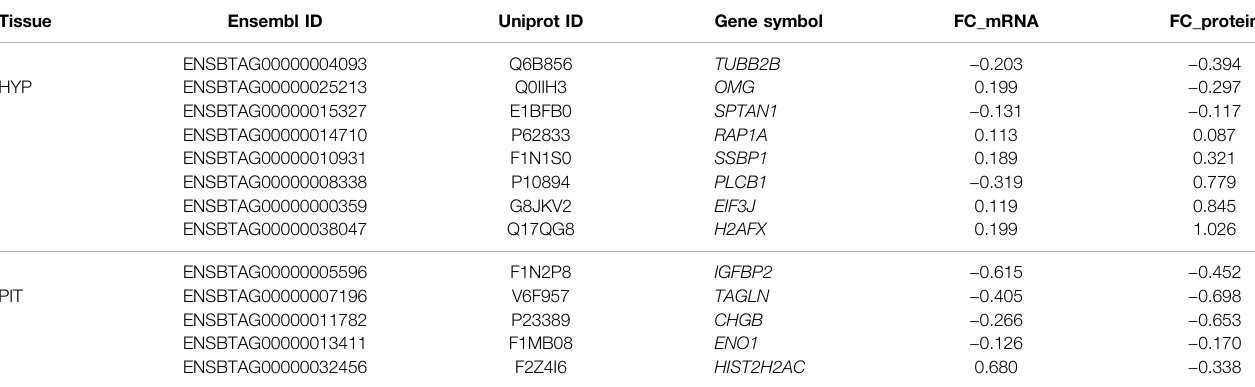
TABLE 1 | List of common differentially expressed genes and abundant proteins in the hypothalamus and pituitary studies. Tissue Ensembl ID Uniprot ID Gene